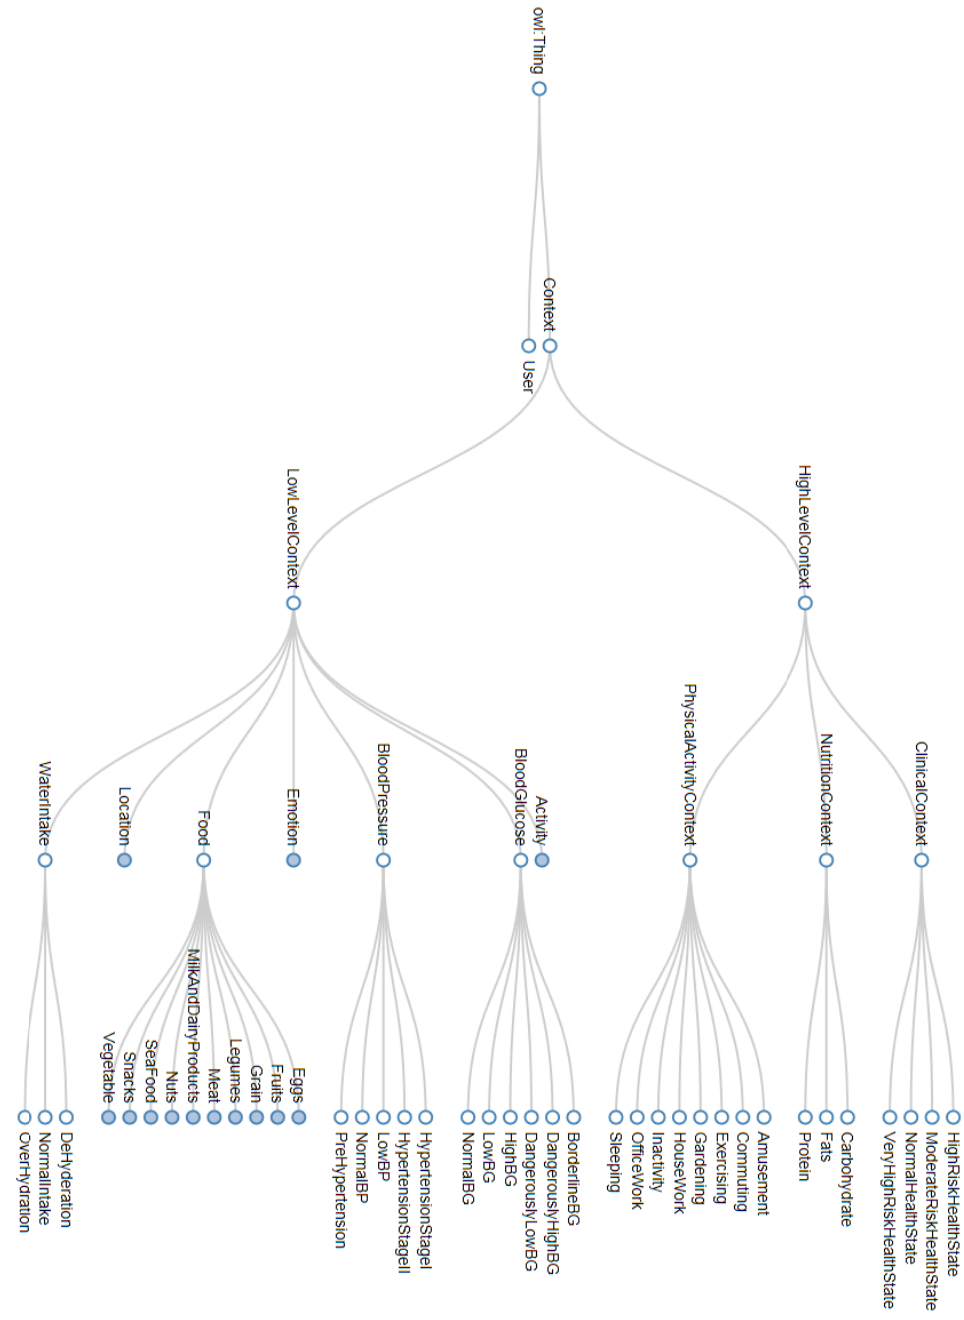
Figure 2. Partial view for extended MMCO: [38]: LowLevelContext class and 7 subclasses, HighLevelContext class with 3 subclasses, i.e., PhysicalActivityContext class with 8 subclasses, NutritionContext class with 3 subclasses and ClinicalContext class with 4 further